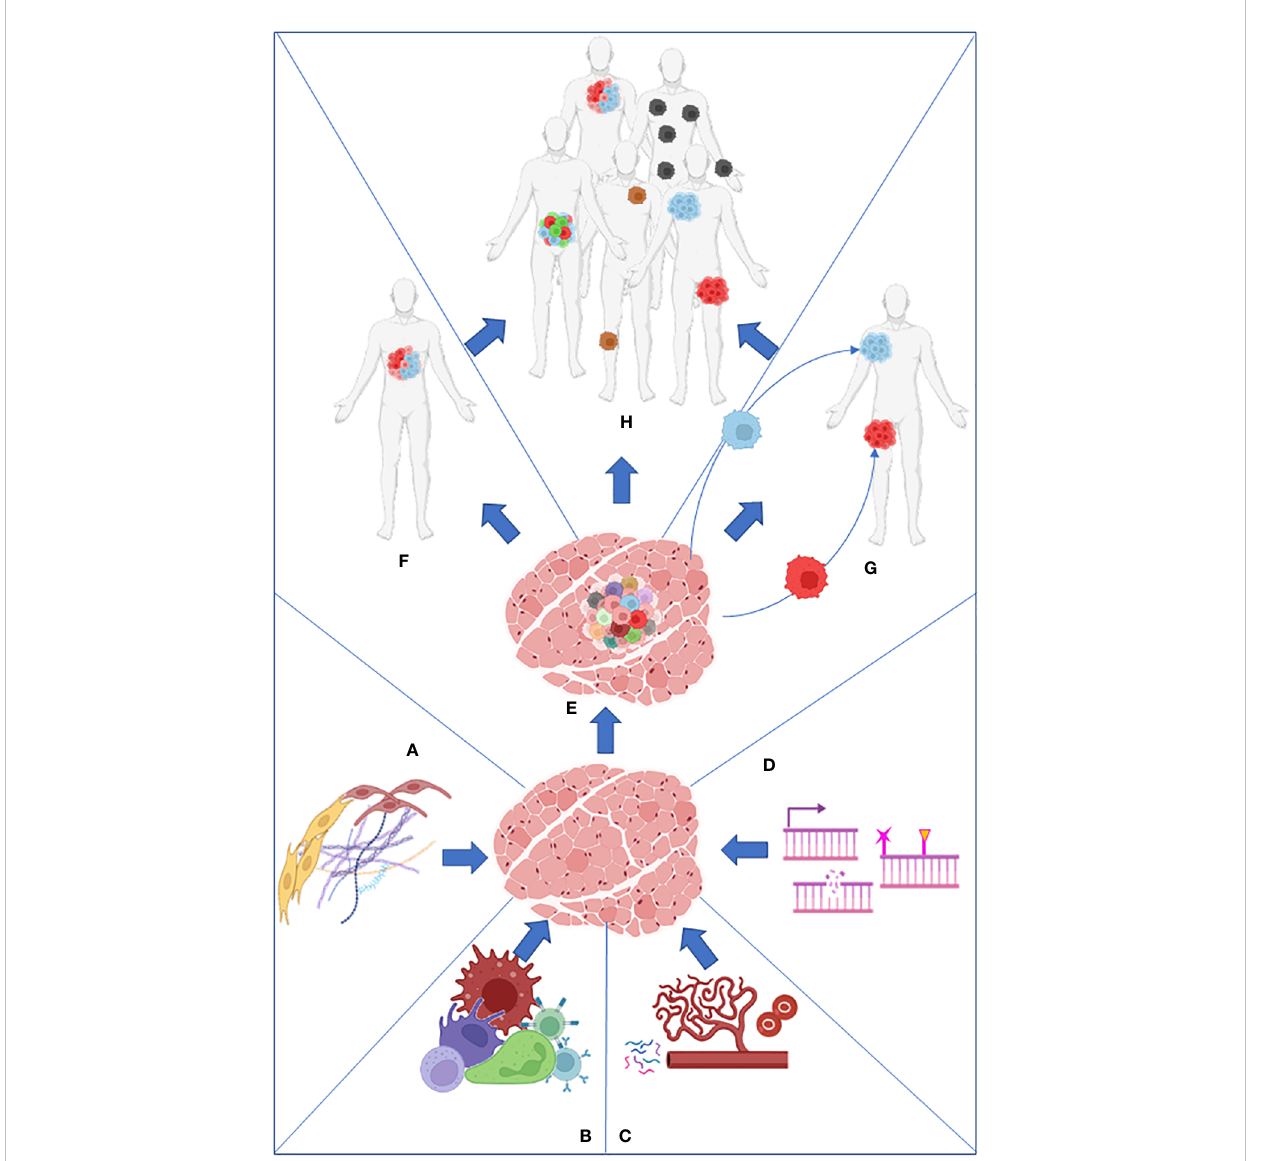
FIGURE 1 Stroma (A) , immune cells (B) , nutrients present in the microenvironment (C) , and intrinsic factors such as DNA damage and epigenome (D) work together to produce the primary tumor heterogeneity (E) . Intratumor heterogeneity can arise from the primary tumor (F) or from its metastasis (G) . Both processes collaborate in the establishment of intertumoral heterogeneity in the population (H)